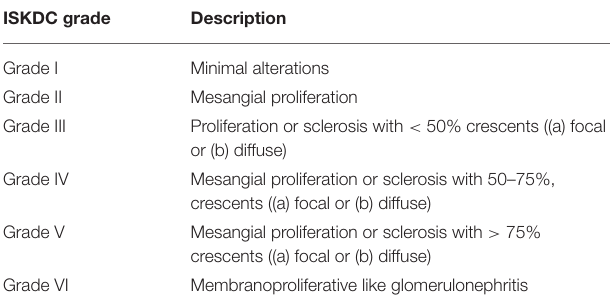
TABLE 5 | Classification of renal lesions in course of Henoch-Schönlein Purpura by the International Study of Kidney Disease in Children (ISKDC). ISKDC